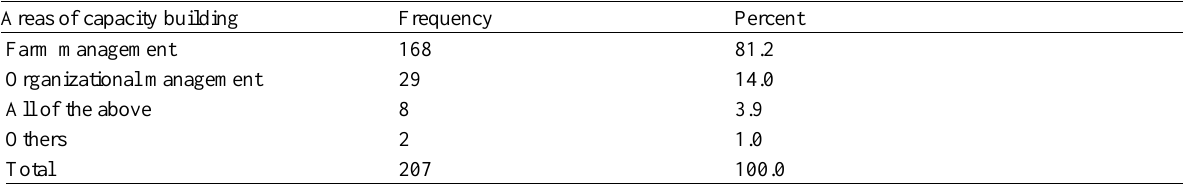
Table 12: Capacity Building Areas in the